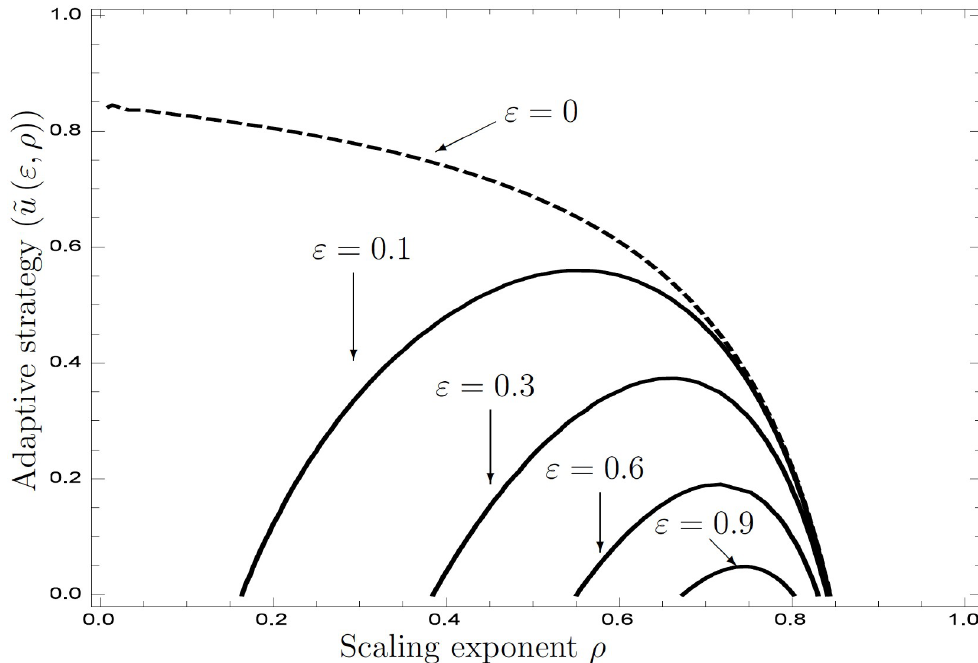
Fig 4. Adaptive resource utilization under external